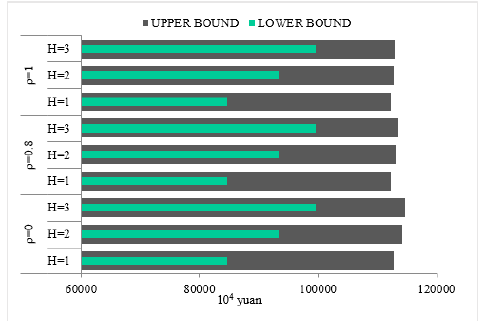
Figure 7. System economic benefits of the Yinma River Basin with different robust coefficients and different scenarios.